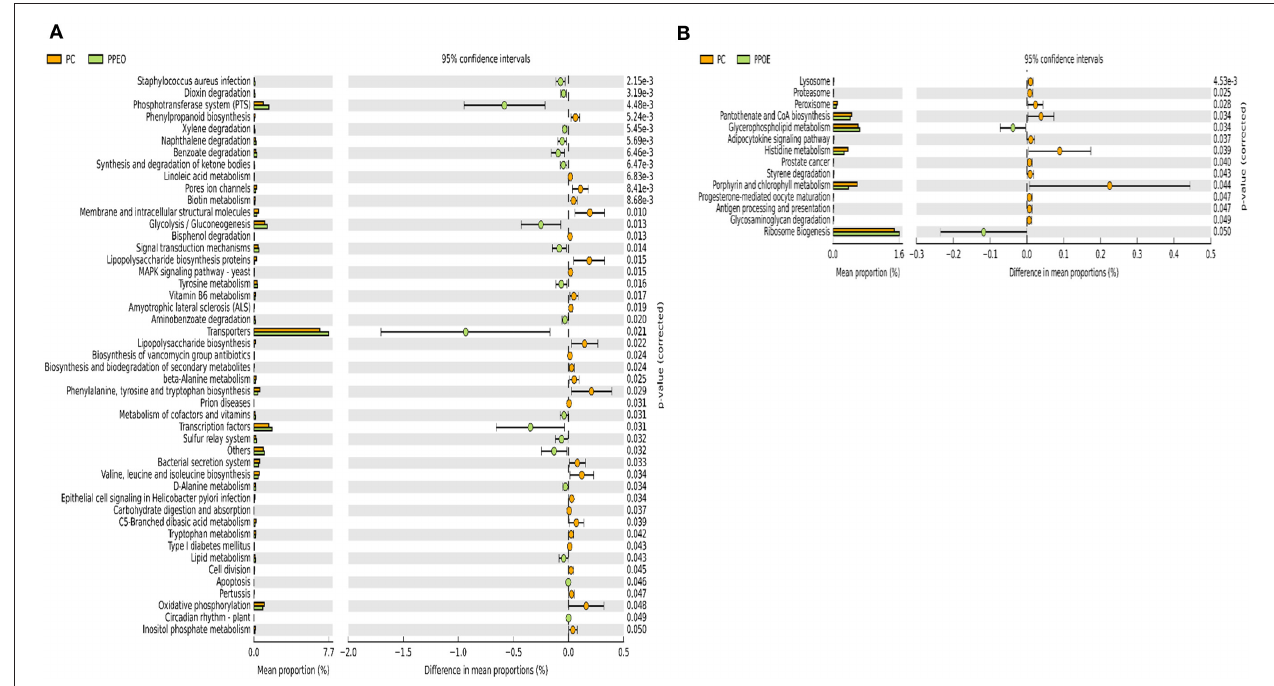
FIGURE 8 | Predicted functions of ileal mucosa microbiota in broiler chickens challenged with a subclinical naturally occurring necrotic enteritis at KEGG levels 3 ( n = 8/treatment). (A,B) Differentially regulated metabolic pathways in PC vs. PPEO group on d 8 and d 42, respectively. PC (positive control): basal diet (corn-soybean